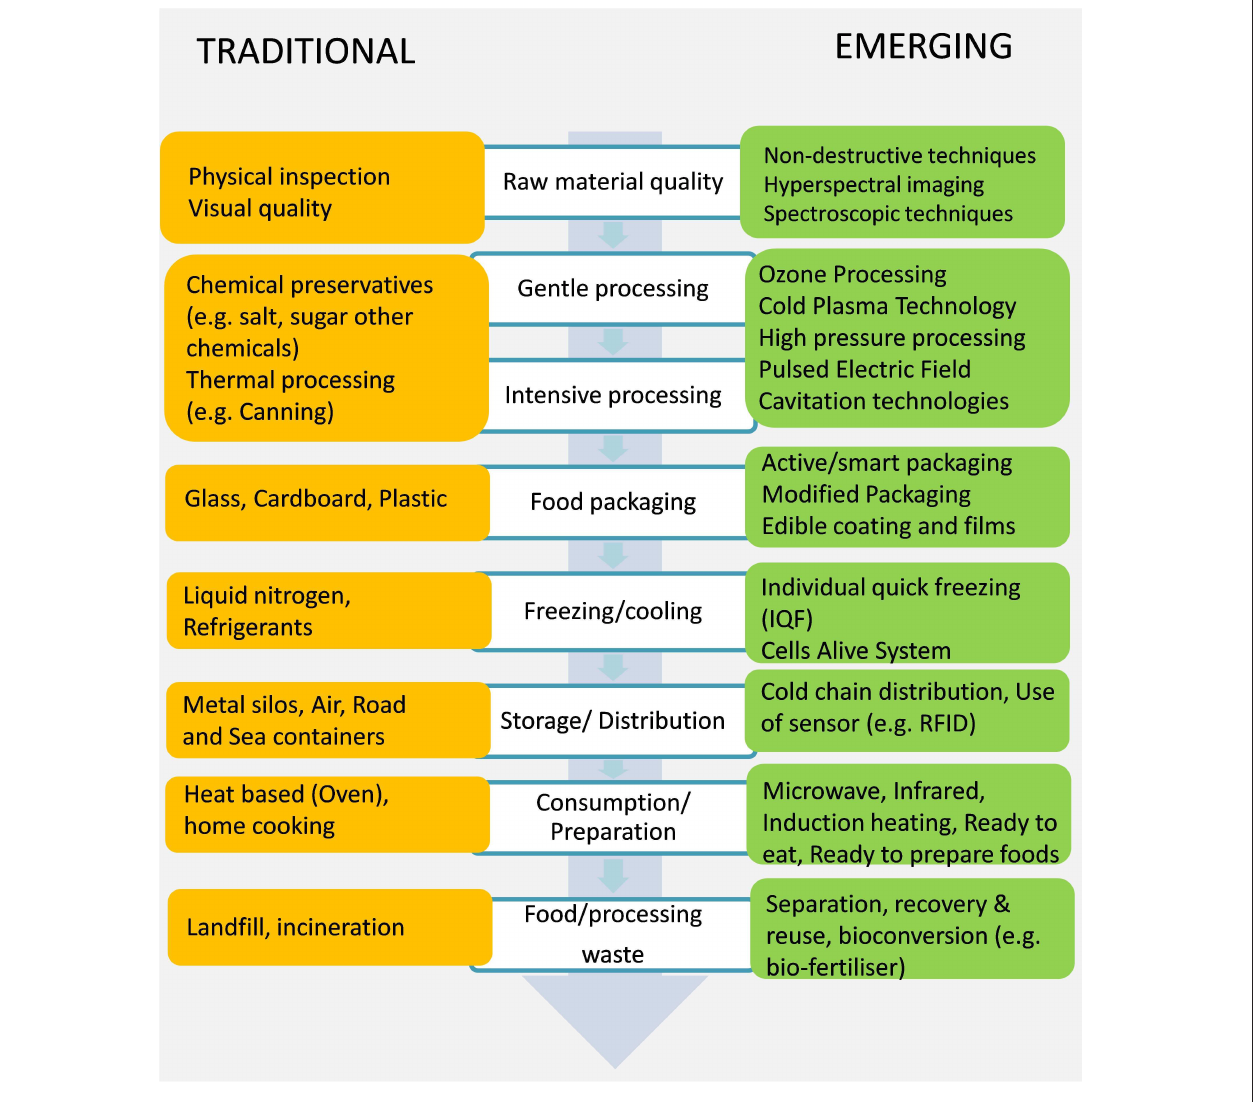
FIGURE 1 | Traditional and emerging technologies and approaches used along the food